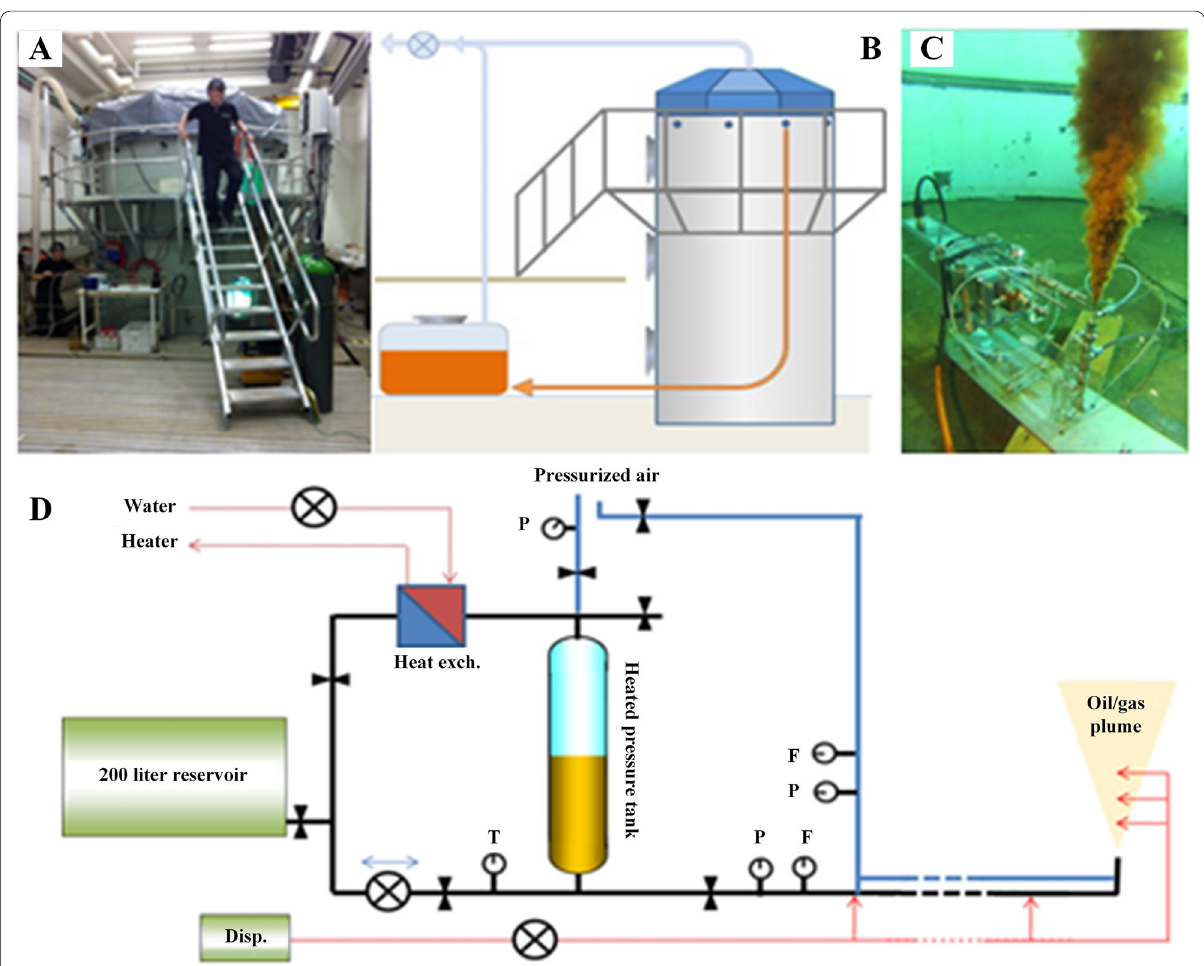
Fig. 5 The tower basin for oil pill test. A the tower basin facility showing the ventilated hood, scaffolding, staircase, and the railings to ensure safe working conditions (Brandvik et al. 2013); B principles for the scaffolding/railing around the tower, ventilated hood and overflow system to collect surface oil from the top of the tower (Brandvik et al. 2013); C view of the oil injection system at the bottom of the Tower Basin (Brandvik et al. 2013); D Principle overview of the set-up showing how oil, gas and dispersant are released during the experiments (Brandvik et al.